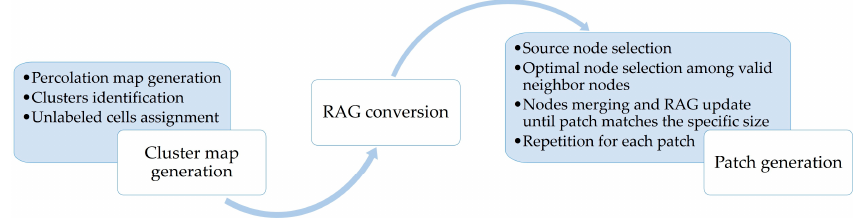
Figure 1. The flow diagram of our method.